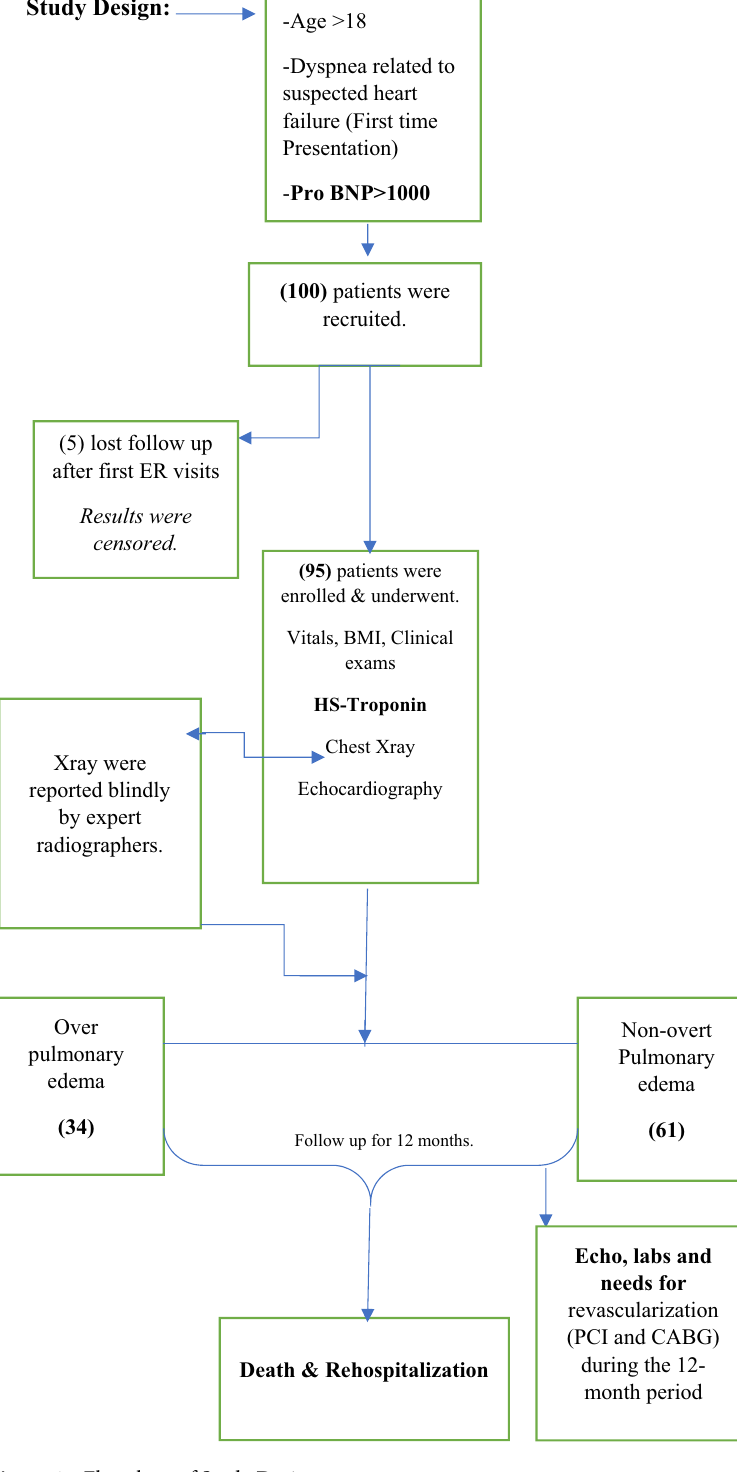
Figure 1. Flowchart of Study